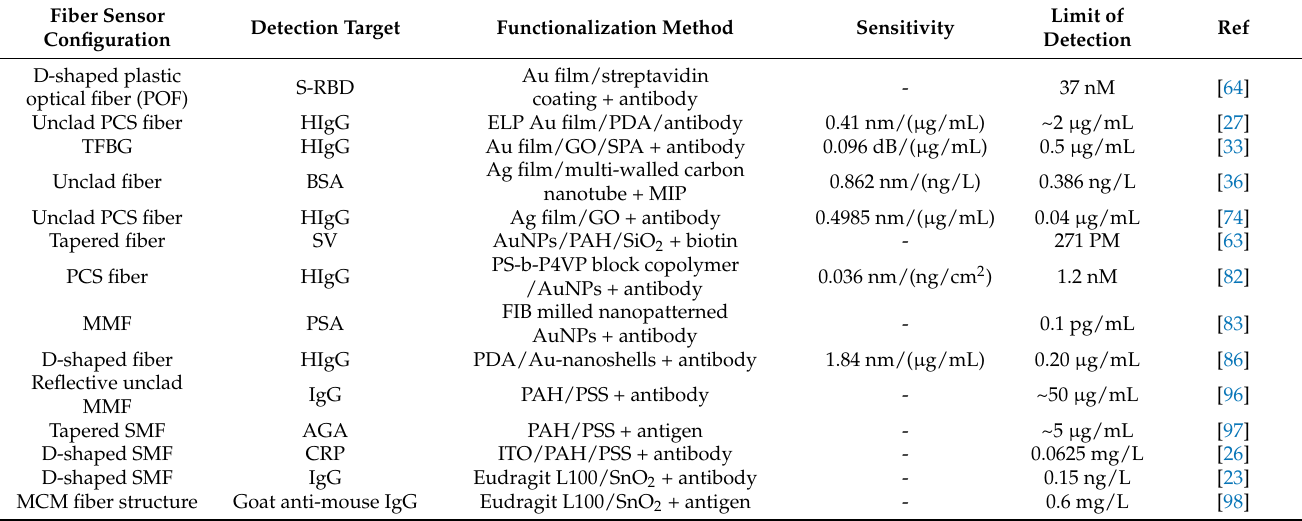
Table 2. EMR-based fiber biosensors for protein